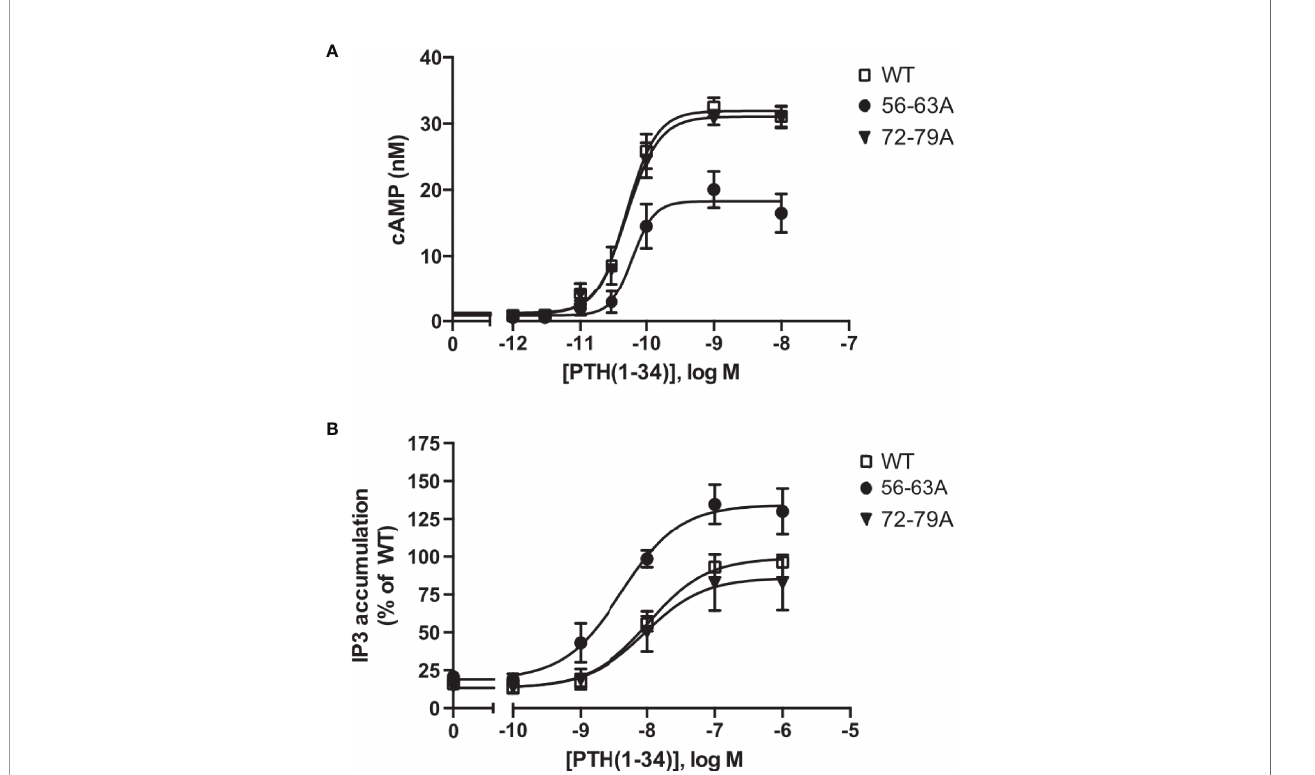
FIGURE 4 | Protease cleavage changes thesignaling speci fi city of PTH1R from G q and G s . (A) Flp-InCHO cells stably expressing PTH1R, PTH1R 56-63A or PTH1R 72-79A were stimulated for 20 minwithPTH(1-34) at the indicated concentrations, and cAMP levels were quanti fi ed with a radioimmunoassay. Themeans ± S.E.M. of fi ve independent experiments are shown. (B) Flp-In CHO cells stablyexpressing PTH1R, PTH1R 56-63A or PTH1R 72-79A were incubatedwith [ myo -2- 3 H(N)]inositol and 0.2% fetalcalfserum for 16 h. Cells were stimulatedfor 60 min with theindicated concentrations of PTH, and[ 3 H]IP 3 levels were quanti fi edin a scintillation counter after chromatographic separation. Data represent themeans ± S.E.M. of fi ve individualexperiments.